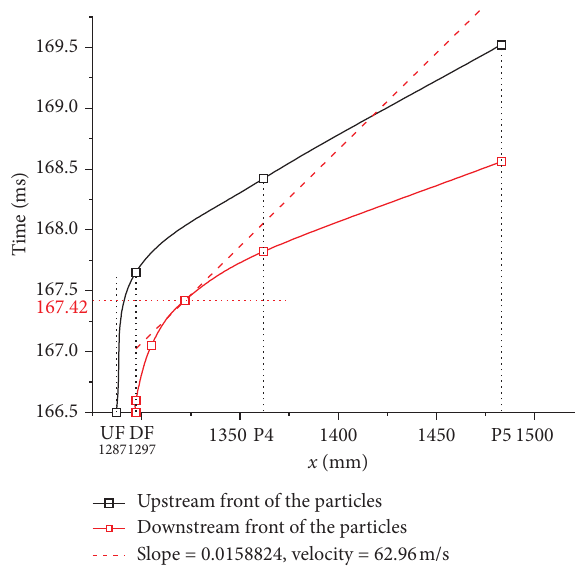
Figure 5: Particle velocities measured in literatures [3, 4] and simulated in this work.